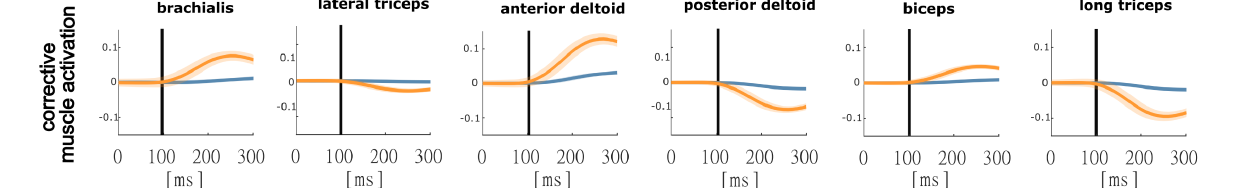
Fig 3. A: Unperturbed and perturbed reaching trajectories predicted in the presence (‘force field’) and absence (‘circle’) of a 200N/m divergent force field. Simulated end-point accuracy ellipses denote 95% confidence regions. B: Simulated muscle-level corrective actions that result from optimal feedback in response to unexpected extension perturbations. C: Horizontal and vertical end-effector stiffness throughout the reaching movement for the optimal controllers in the absence and presence of the divergent force field, and for the other reaching tasks (in absence of the force field). D: Average muscle co- contraction level for the uni-articular shoulder and elbow muscles and the bi-articular muscles in the presence and absence of the force field while reaching to the circle.